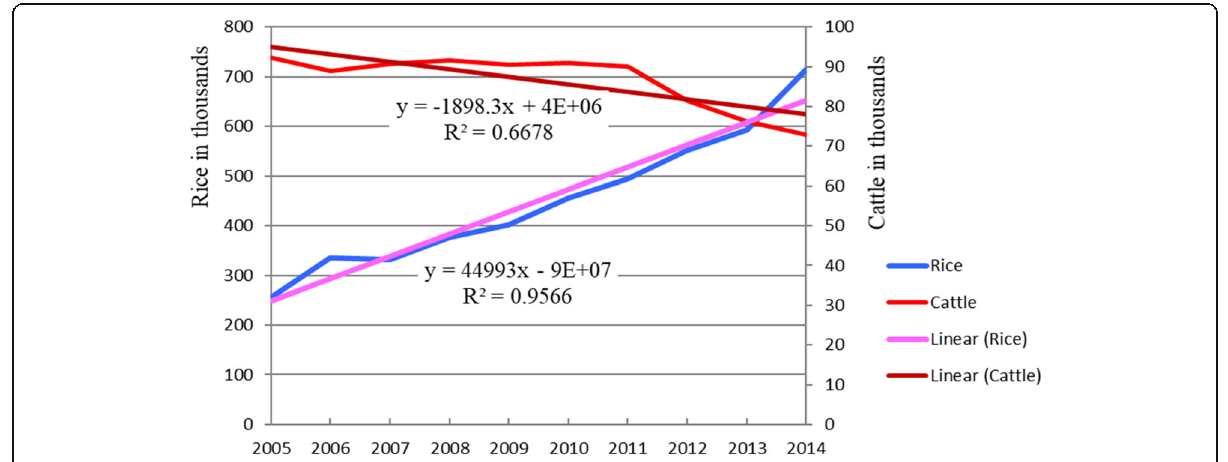
Fig. 6 Trends of cattle population and rice production in the sample kebeles from 2005 to